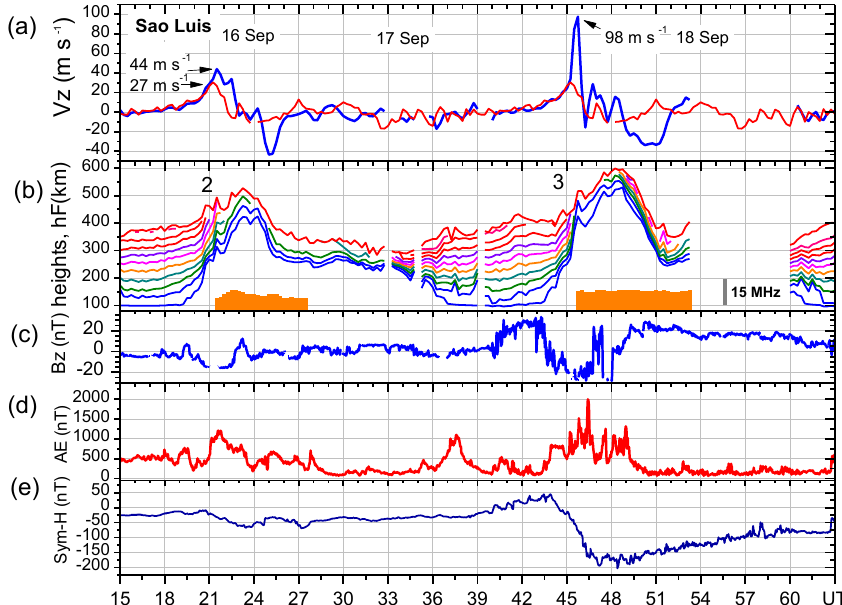
Figure 3. Panels from top to bottom show variations in the following parameters during 16–18 September 2000: (a) the vertical drift ( V z ; blue curve) obtained as mean of those calculated at four plasma frequencies, 4, 5, 6, and 7MHz, with the quiet day reference curve shown in pink. The digisonde data are taken at 15min cadence. The V z values (blue curve) plotted are smoothed values representing 4-point running mean. There is a break in the data between 02:30 and 09:00LT; (b) the F layer heights at fixed plasma frequencies at 1MHz interval from 3 to 12MHz (color coded) and the fop parameter (in orange) indicative of the spread F intensity in MHz (scale inset); (c) The interplanetary magnetic field z component, B z ; (d) the auroral activity index AE; (e) the Sym-H/Dst index at 1min interval. Please note that the UT on the x axis is cumulative with increasing number of